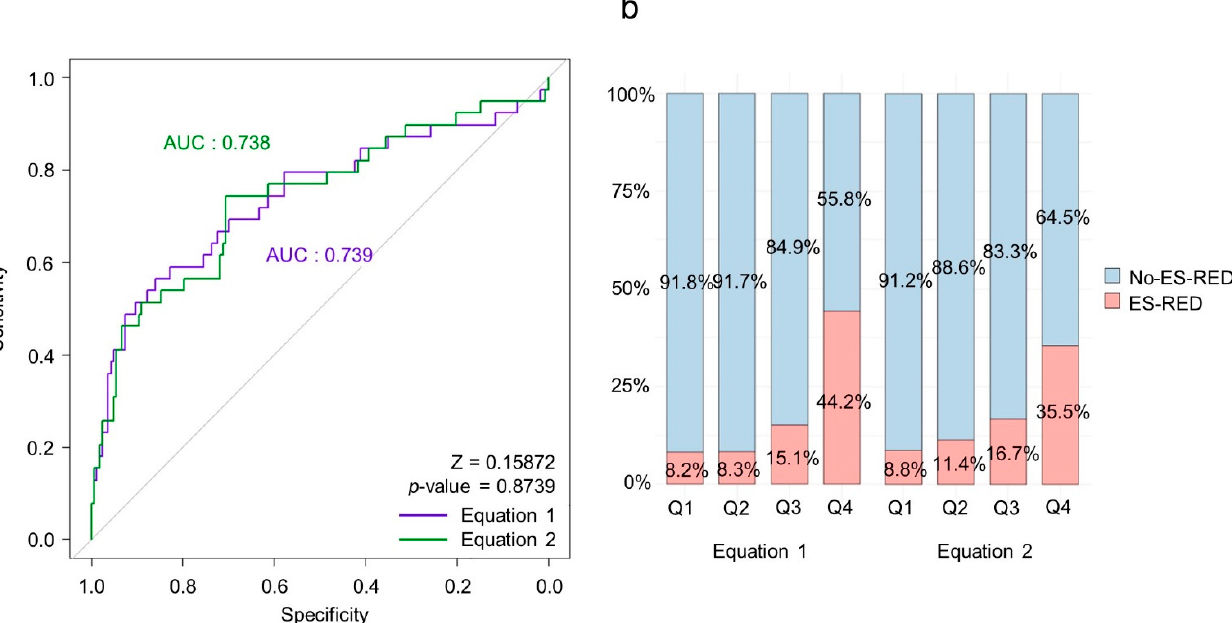
Figure 2. Predictive performance of equations in the validation cohort. ( a ) Receiver operating char- acteristic (ROC) curve analysis of both equations. ( b ) Frequency of early seizure recurrence in the emergency department (ES-RED) by quartiles in both Equations. ( c ) Cumulative incidence of ES- RED over time by quartiles in Equation (1). ( d ) Cumulative incidence of ES-RED over time. 4. Discussion In this single-center, retrospective cohort study of adult patients presenting with re- solved seizures, we generated prediction models after exploring the factors associated with ES-RED. We found that clinical and laboratory parameters can successfully predict ES-RED, thereby developing two prediction models. Between the two equations, due to Equation (1) being simpler, having a slightly better predictive performance, and requiring fewer variables than Equation (2), we propose using Equation (1) as an ES-RED calculator to predict ES-RED.